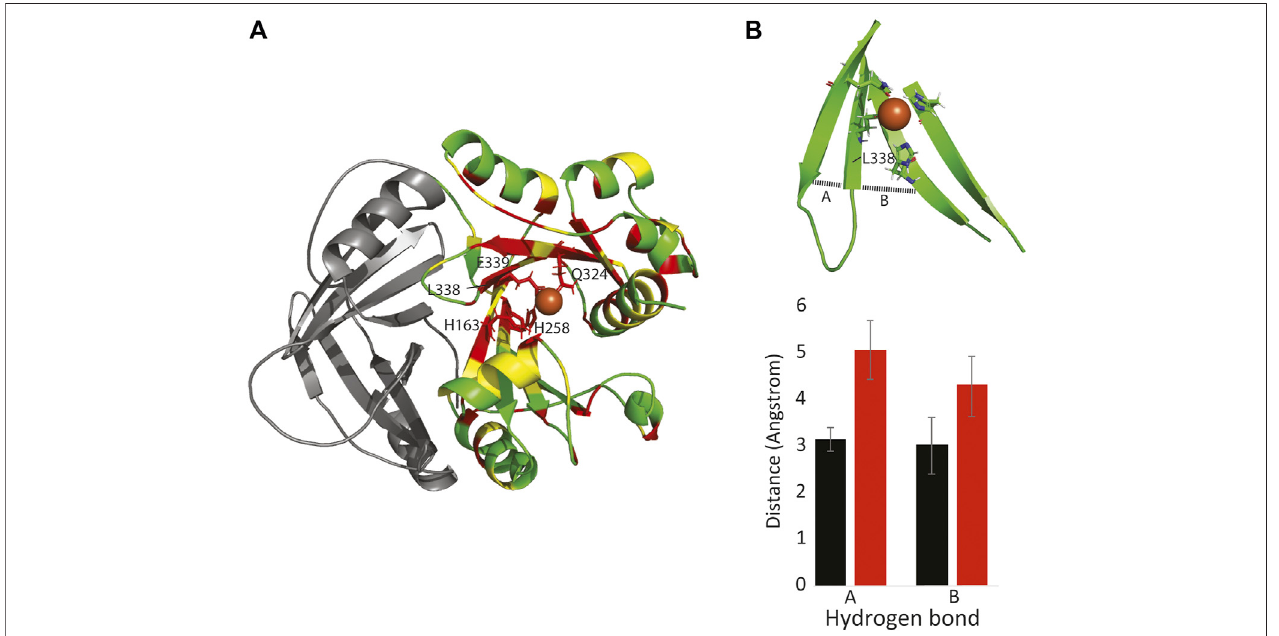
FIGURE 3 | The Leu338Pro mutation disrupts HPDL structure and function. (A) : Model of one subunit of HPDL, based on the HPPD structure. Identical residues between HPPD and HPDL are colored red, similar residues are colored yellow. The N-terminal dimerization domain is colored in gray. Note that the four iron-binding residues are conserved between the two proteins, as are most residues surrounding the putative iron binding site. (B top) : HPDL Leu338Pro model showing how the beta strands that neighbor Pro388 dissociate. (B bottom) : This separation is due to a lack of inter-strand hydrogen bonds involving Pro338, along with missing hydrogen bonds between residues 327-337 (A) and 327-257 (B)